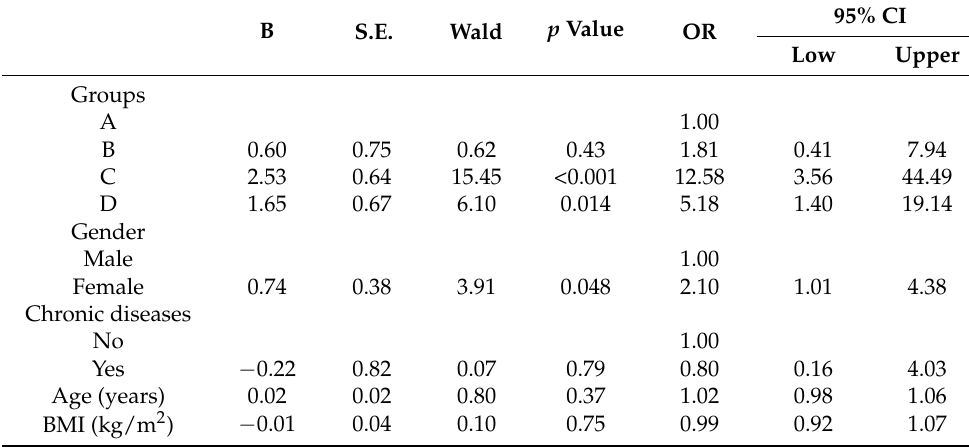
Table 3. Odds ratio for risk of injection site reactions after a vaccine booster.